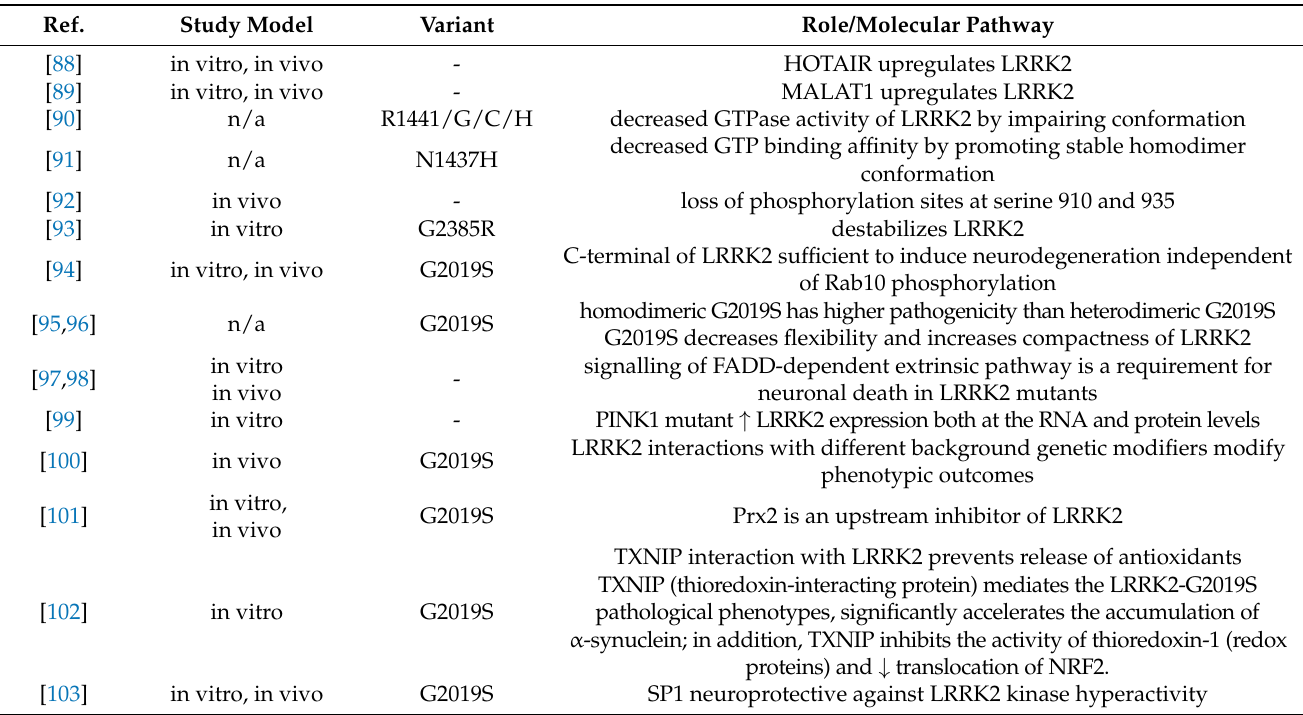
Table 14. Factors that control LRRK2 expression and its